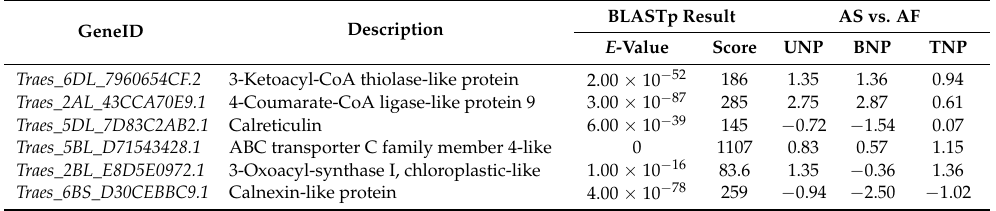
Table 3. Differentially abundant proteins related to pollen wall formation in fertile and sterile plants. GeneID